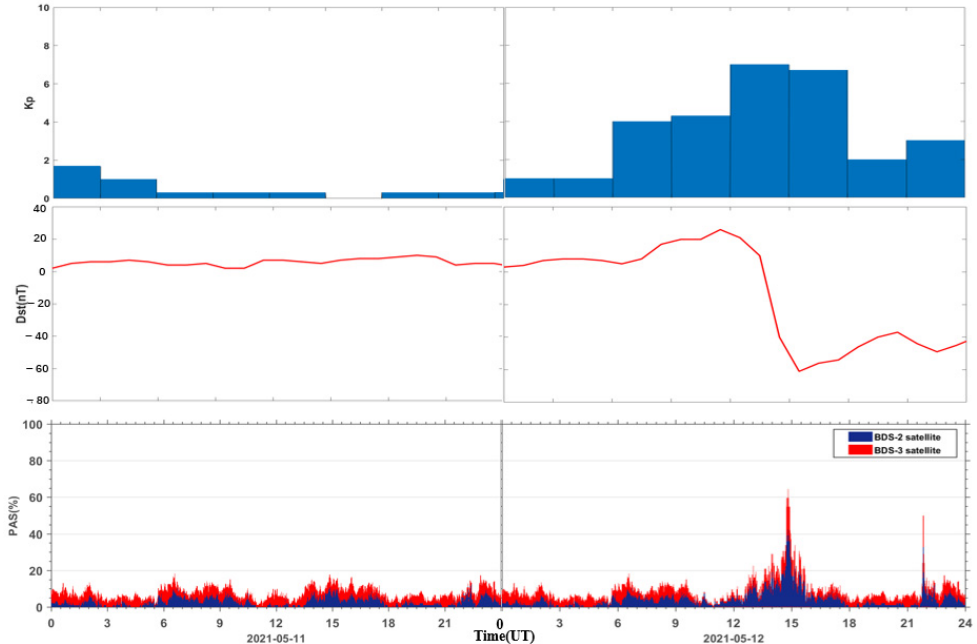
Figure 9. Relationship between the PAS index of global BDS sites affected by the geomagnetic storm and the geomagnetic indices Kp, Dst. and the geomagnetic indices Kp,